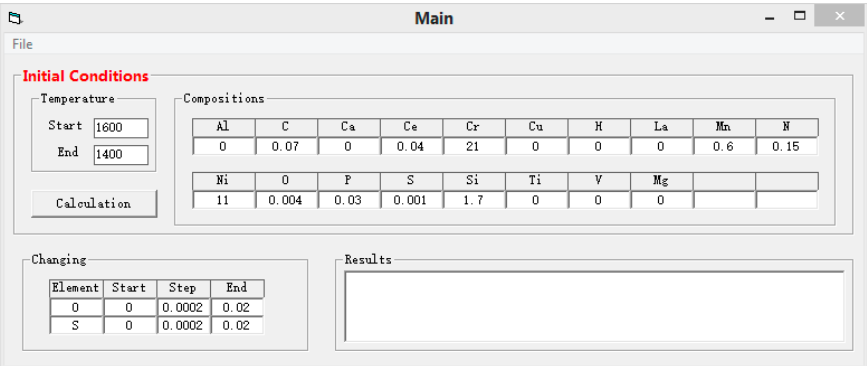
Figure 2. Main interface of the developed program.